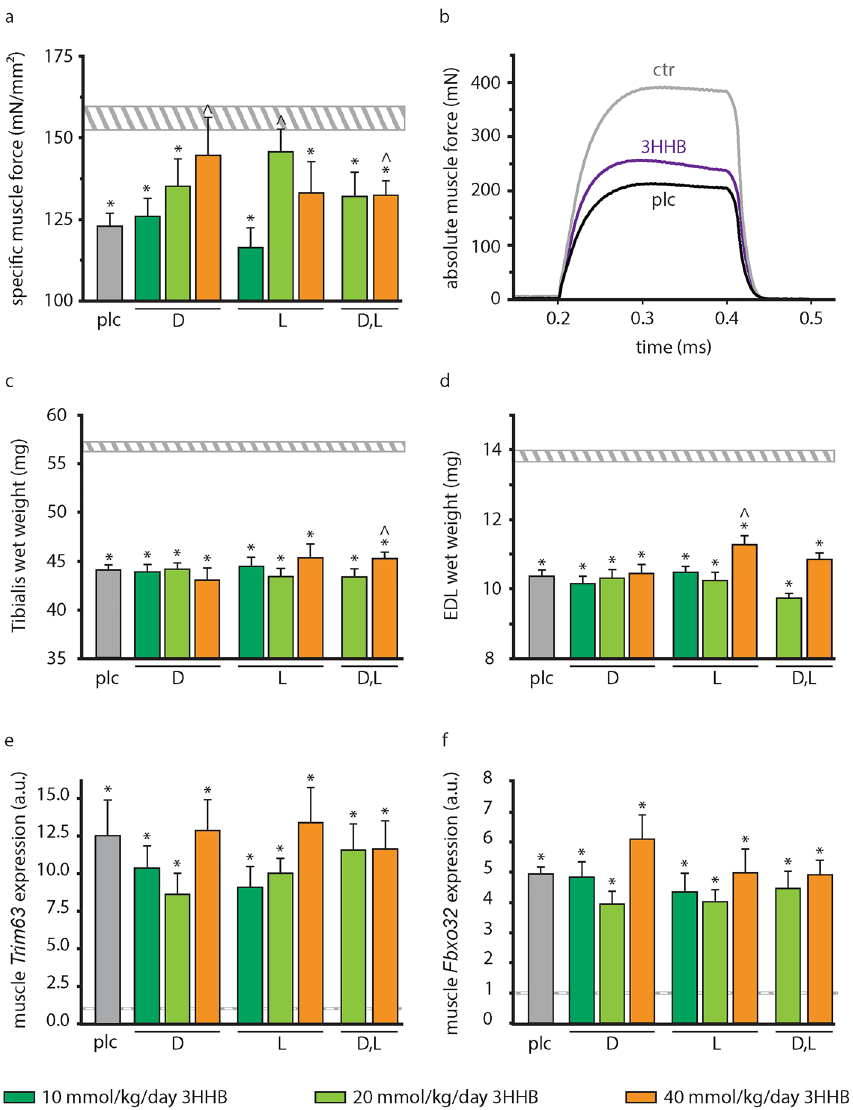
Figure 2. Impact of increasing bolus doses of pure and mixed racemic enantiomers of 3HHB on muscle force, muscle mass and muscle atrophy markers. ( a ) Ex vivo EDL force measurements presented as peak tetanic tension per unit muscle mass. Horizontal bars: white–grey shaded, healthy control (n = 62); grey, placebo (n = 67); vertical bars: d-3HHB: 10 mmol/kg/day (n = 17); 20 mmol/kg/day (n = 19); 40 mmol/kg/day (n = 16); l-3HHB: 10 mmol/kg/day (n = 15); 20 mmol/kg/day (n = 18); 40 mmol/kg/day (n = 14); d,l-3HHB: 20 mmol/ kg/day (n = 15); 40 mmol/kg/day (n = 17). ( b ) Example of ex vivo-measured absolute maximal tetanic EDL muscle force presented as force tracings. 3HHB: 40 mmol/kg/day d,l-3HHB ( c ) Tibialis anterior and ( d ) EDL muscle wet weight. ( e , f ) Relative mRNA expression of muscle atrophy markers Trim63 ( e ) and Fbxo32 ( f ). Gene expression data are normalized to Rn18s and were expressed as a fold change of the mean of control mice. ( a , c-f ) Data are shown as mean ± standard error of the mean. Horizontal bar: healthy control (n = 80); vertical bars: placebo (n = 74); d-3HHB: 10 mmol/kg/day (n = 18); 20 mmol/kg/day (n = 19); 40 mmol/kg/day (n = 16); l-3HHB: 10 mmol/kg/day (n = 15); 20 mmol/kg/day (n = 19); 40 mmol/kg/day (n = 14); d,l-3HHB: 20 mmol/kg/ day (n = 16); 40 mmol/kg/day (n = 17). EDL Extensor digitorum longus, ctr healthy control, plc placebo, 3HHB 3-hydroxybutyl-3-hydroxybutanoate ester. *p ≤ 0.05 vs healthy control; ^ p ≤ 0.05 vs